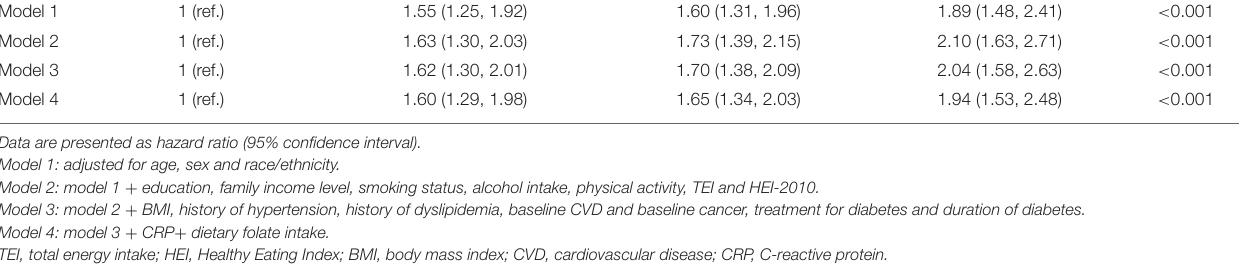
TABLE 2 | Odds ratios of diabetes according to RBC folate status. Odds ratio (95%CI) of prevalence of diabetes Q1, < 121ng/mL, n = 3,924 Q2, 122–161ng/mL, n =